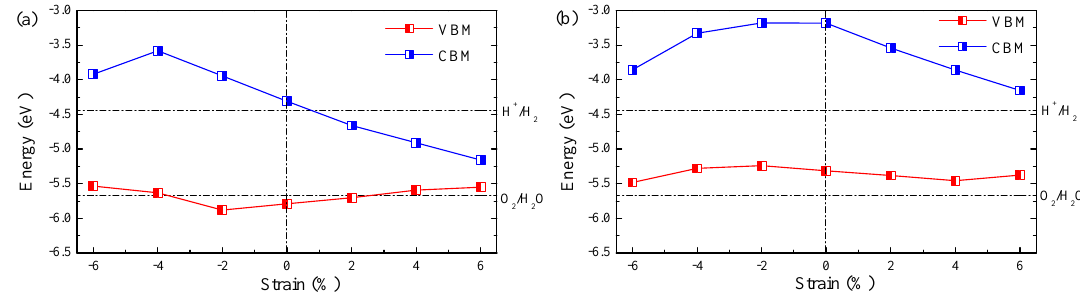
Figure 5. Band alignment of ( a ) ZnO/WS 2 and ( b ) ZnO/WSe 2 with different